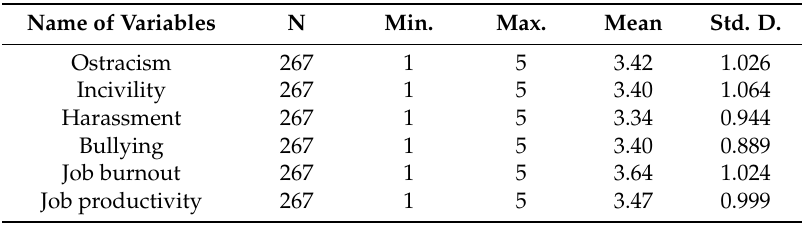
Table 4. Results of Descriptive